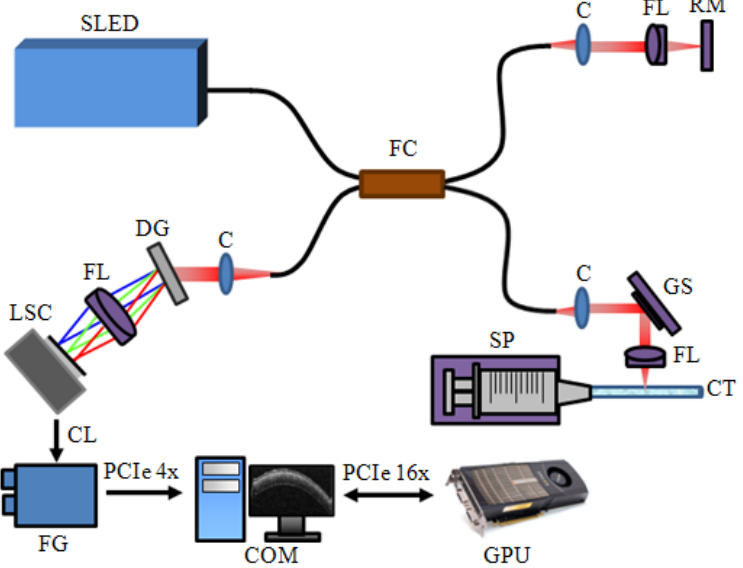
Figure 1. Schematic of the SD-ODT system. C: Collimator. FL: Focusing lens. RM: Reference mirror. FC: 2 × 2 Fiber coupler. LSC: CMOS Line scan camera. DG: Diffraction grating. GS: Galvanometer scanner. SP: Syringe pump. CT: 750 µm Capillary tube. PCIe: PCI express. FG: Frame grabber. COM: Host